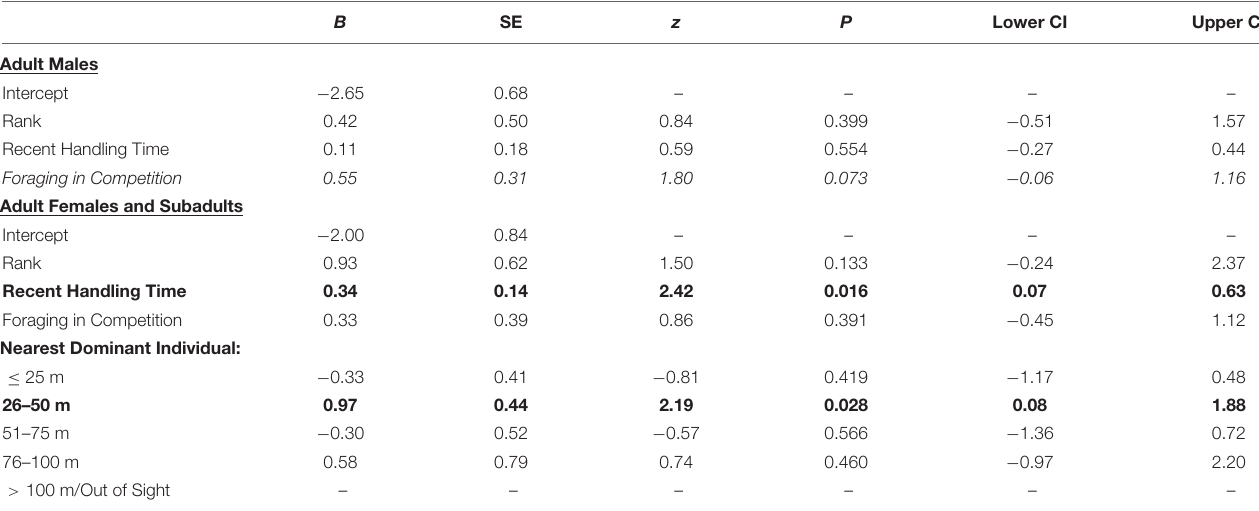
Significant fixed effects are bolded and trends are italicized. The adult male model did not perform significantly better than the null model, which contained only the intercept and random effects [Likelihood ratio test: N = 572, X 2 = 4.69, P = 0.196, delta R 2 GLMM ( c ) = 0.27], however, the model for adult females and subadults did